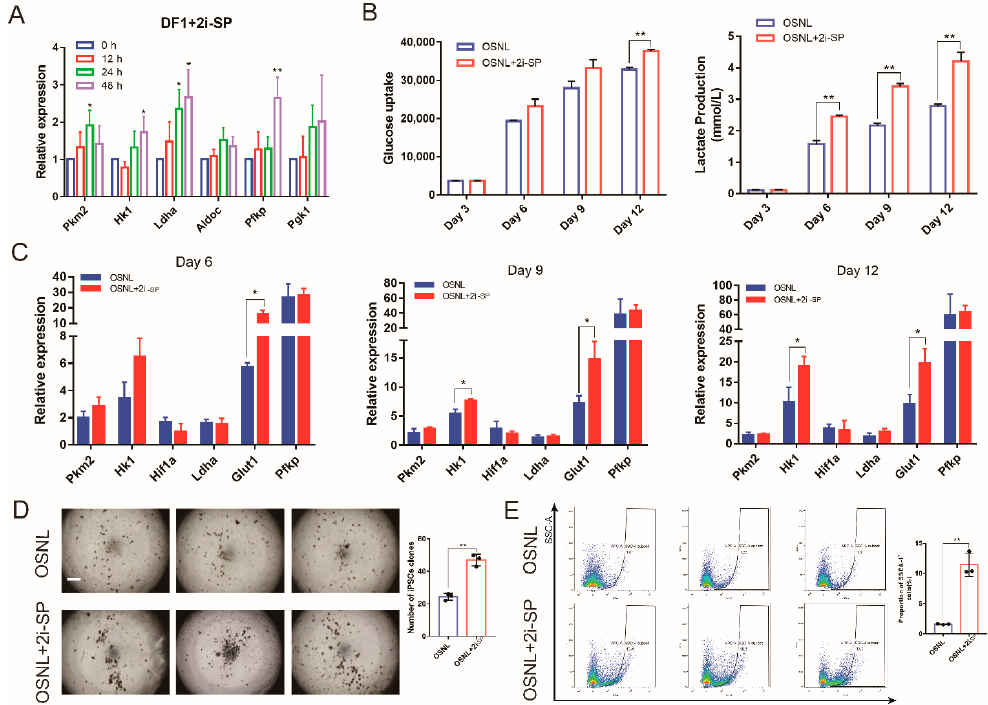
Figure 6. 2i-SP increases glycolysis level to promote chicken iPSC formation. ( A ) qRT-PCR analysis of expression of genes encoding related enzymes in glycolysis after adding 2i-SP (SB431542, PD0325901) to DF-1. ( B ) Changes in glucose uptake and lactate production after adding 2i-SP. ( C ) qRT-PCR analysis of expression of genes encoding related enzymes in glycolysis after adding 2i-SP. ( D ) Changes of cell morphology and the number of chicken iPSC clones after adding 2i-SP. Scale bars = 100 µ m. ( E ) The proportion of SSEA-1 positive cells after adding 2i-SP was detected by flow cytometry. * Represents p < 0.05 and ** represents p < 0.01.